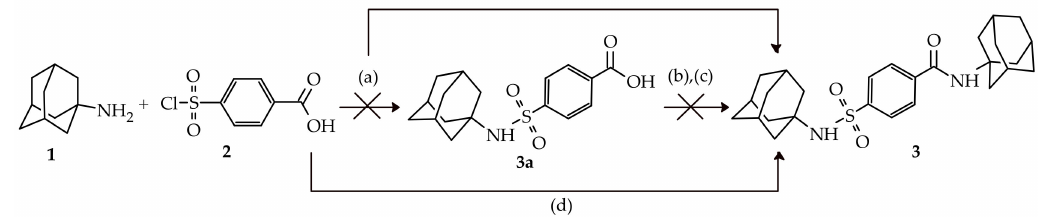
Figure 1. Initial proposed synthesis route for 3 via intermediate 3a (steps a–c). Actual one step synthesis of compound 3 either through step (a) or optimized step (d). Reagents and conditions: (a) 1:1 ratio of 1 and 2, 25 ◦ C, CHCl 3 , triethylamine, 48 h; (b) reflux, DMF, CH 2 Cl 2 , thionyl chloride, 2 h; (c) 25 ◦ C, 1 eq amantadine ( 1 ), CHCl 3 , triethylamine, until completion; and, (d) 2:1 ratio of 1 and 2 , MW, 100 ◦ C, 150 W, 250 psi, CHCl 3 , triethylamine, 30